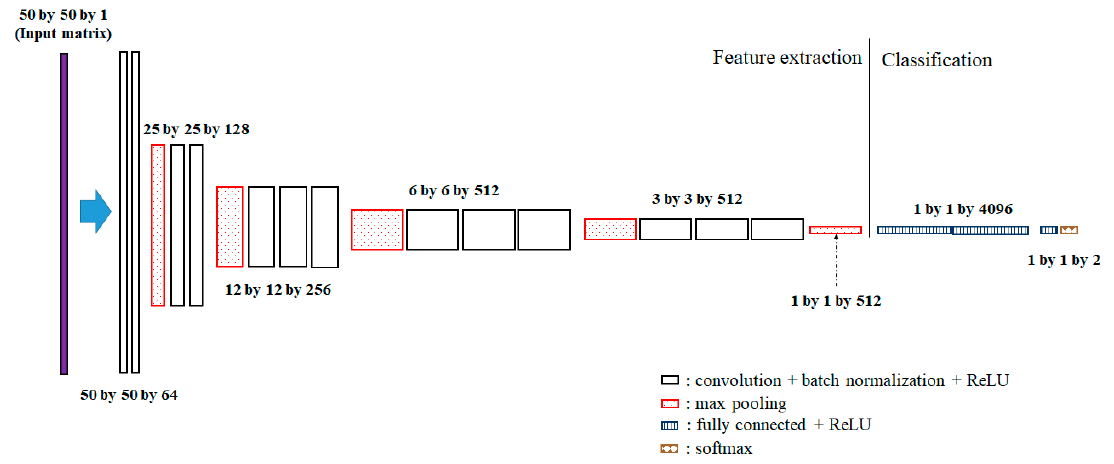
Figure 4. VGG16 architecture and its dimensions used in this study. Note that the input data has a matrix form and the fully connected layers are used for classification.